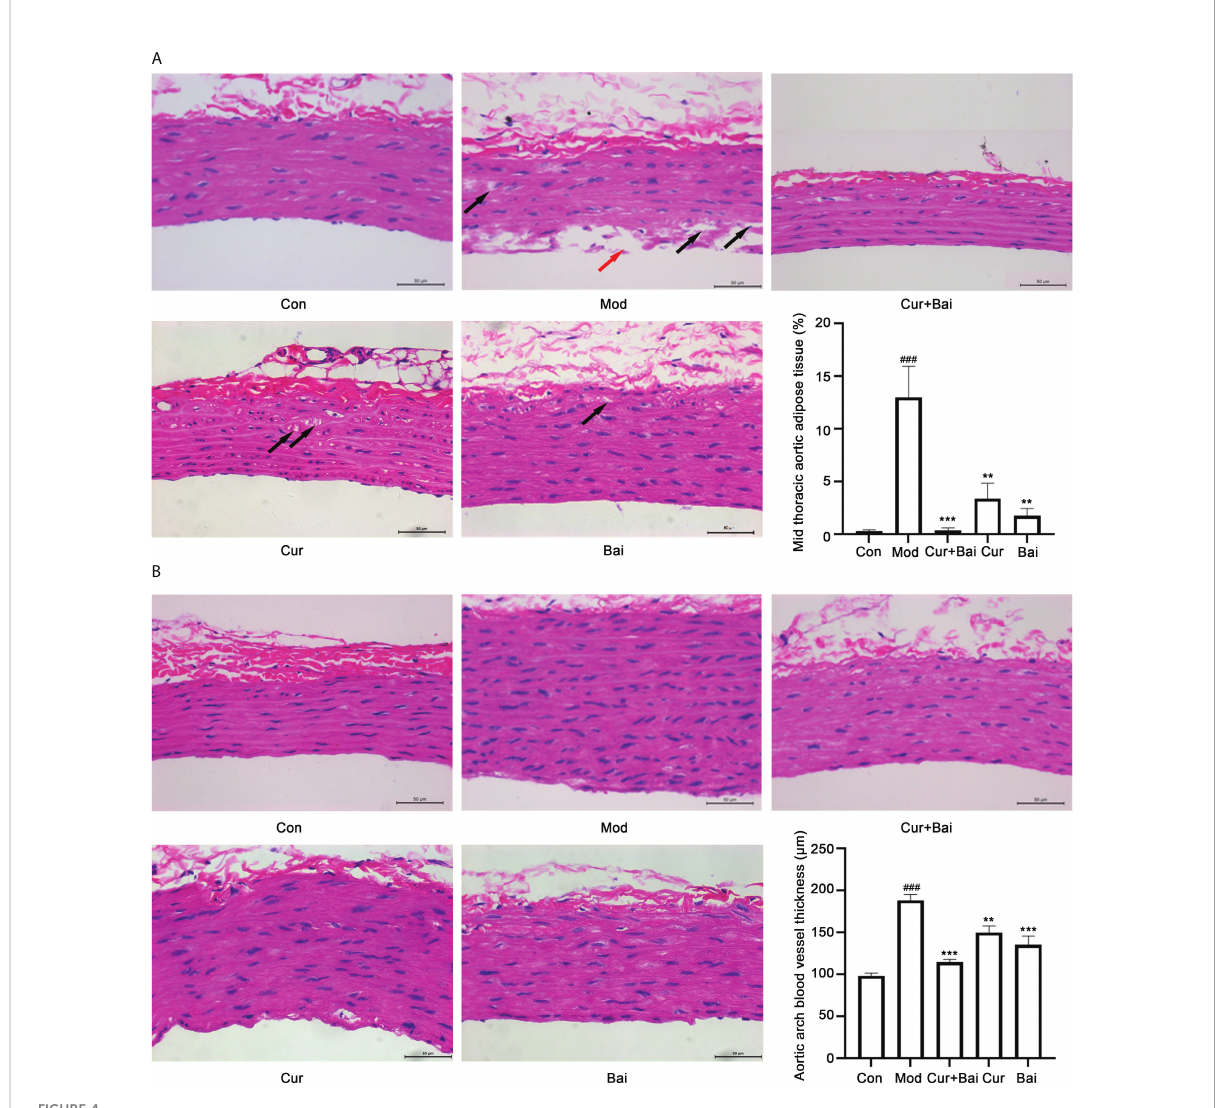
FIGURE 4 The treatments of Cur+Bai, Cur and Bai repaired the blood vessel morphology in both mid thoracic and aortic arch tissue in the diabetic rats. (A) Representative pathological staining of blood vessel tissue in the mid thoracic aorta in the control, model, Cur+Bai, Cur and Bai treated groups (n=5 per group). Scale bar = 50 um. Red arrow points to the injured inner surface of the blood vessel. Black arrows point to the adipose tissue in the middle layer of the blood vessel. The statistical analysis on the mid thoracic aorta adipose tissue (percentage) in fi ve groups. Dynamic Med 6.0 microscopic image analysis system was used for the quantitative analysis of adipose tissue in the aorta. The adipose tissue in the aorta (%) was calculated as below: Aorta adipose tissue (%) = the sum of adipose tissue areas in the H&E staining area/total area of the blood vessel in the same H&E staining area* 100%. ### p <0.001 vs. Con group. ** p <0.01, *** p <0.001 vs. Mod group. (B) Representative pathological staining of blood vessel tissue in the aortic arch in the control, model, Cur+Bai, Cur and Bai treated groups (n=5 per group). Scale bar = 50 um.